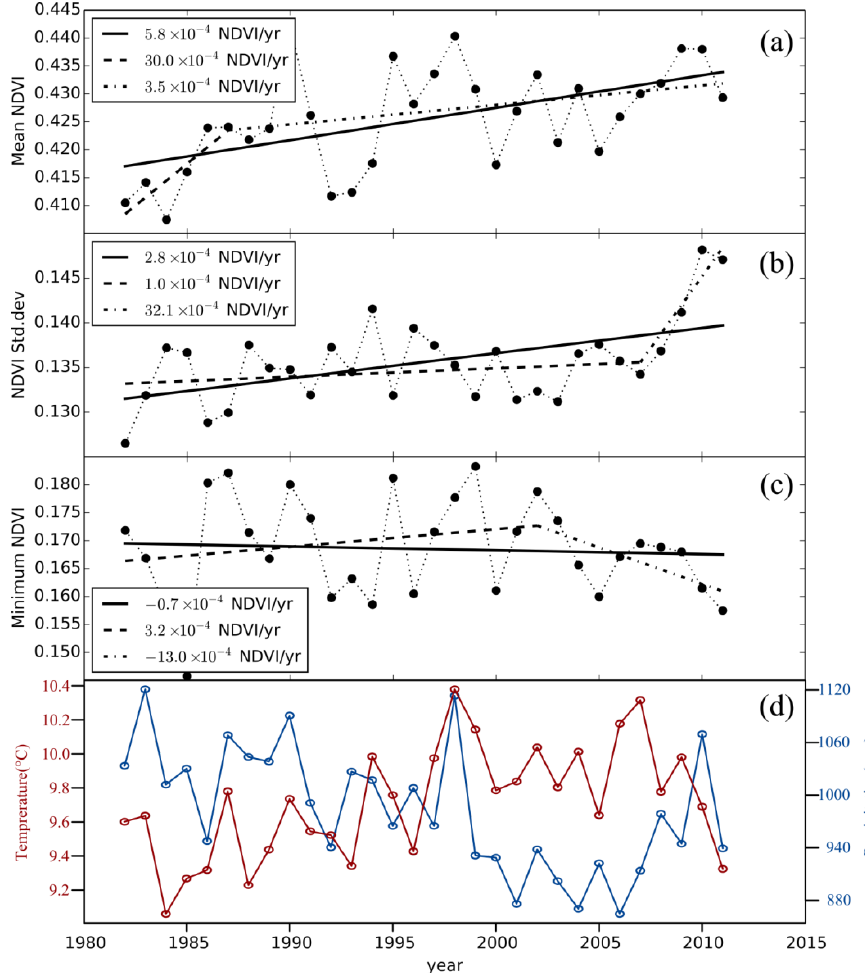
Figure 2. Trends of ( a ) annual mean; ( b ) standard deviation and ( c ) minimum of NDVI and ( d ) air temperature/precipitation, from 1982 to 2011. Solid line is the linear regressive line. The dashed line is piecewise regressive